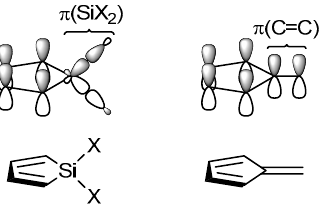
Figure 1. Local π (SiR 2 ) fragment orbitals interact in a similar way as exocyclic local π (C=C) orbitals, giving an electronic structure similarity between siloles and pentafulvenes.